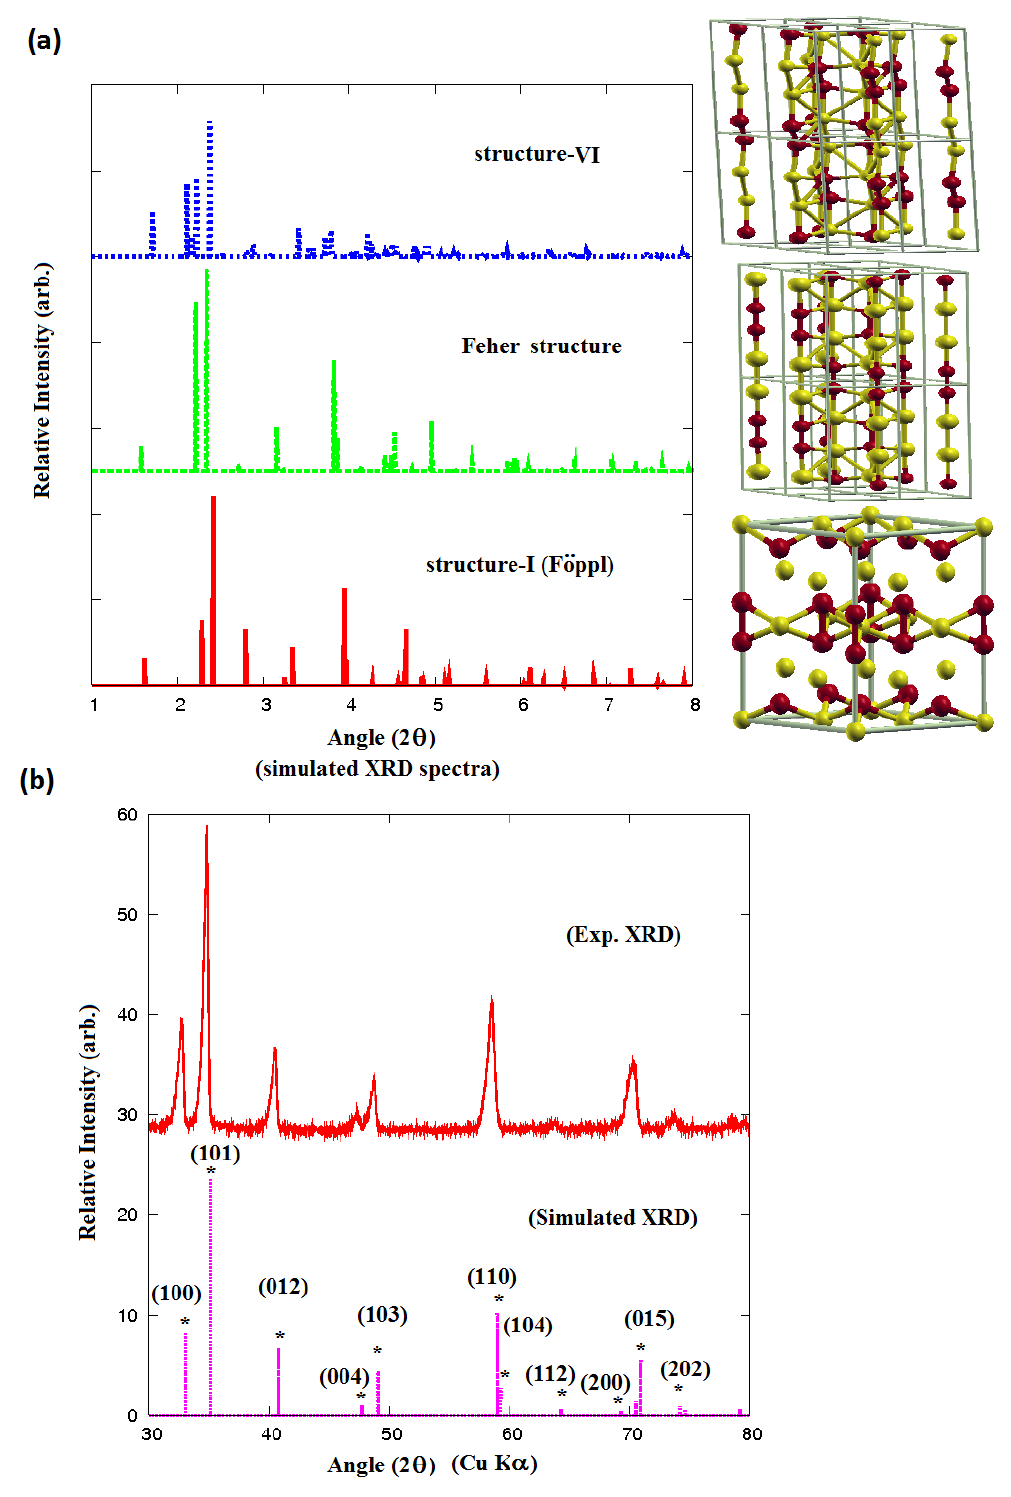
Figure 4. ( a ) The simulated XRD of the Föppl structure), the originally proposed Fehér structure [17], and structure-VI ( i.e. , the modified Fehér structure) based on the X-rays wave-length, λ = 0.10798 Å, the same as in a previous experimental study [24]; ( b ) The experimental XRD of a commercial Li 2 O 2 (Sigma-Aldrich) powder compared with the simulated XRD of the Föppl structure (X-rays wave-length, λ = 1.5406